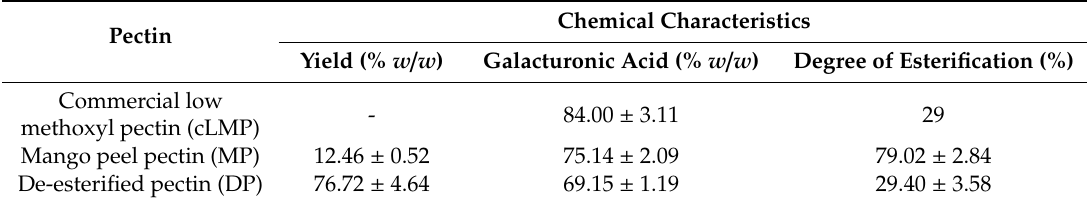
Table 2. The chemical characteristics of